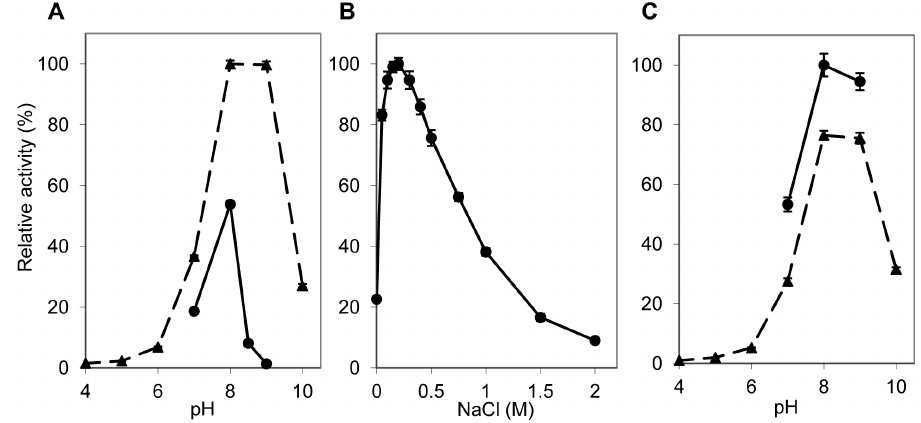
Figure 2. Effects of pH and NaCl on alginate lyase activity of AlgMsp. (A) Effect of pH in the absence of NaCl on activity in 20 mM Tris (circles) or BP buffer (triangles). (B) Effect of NaCl on activity in 20 mM Tris buffer pH 8. (C) Effect of pH on activity in the presence of 200 mM NaCl in 20 mM Tris (circles) or BP buffer (triangles). Activity determined by the initial velocity of increase in absorbance at 235 nm over a 10 minute incubation at 25 u C. Activity was normalized to 100% for the most active